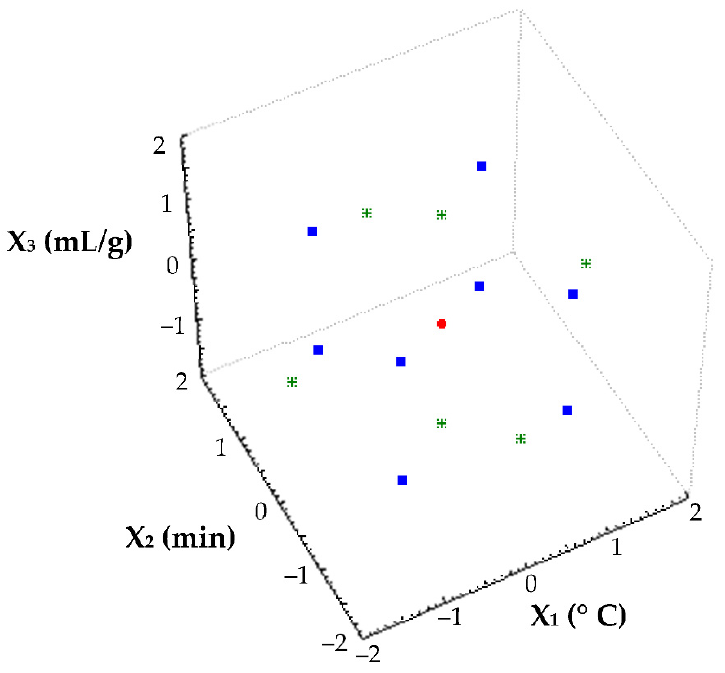
Figure 1. Standard CCD characteristics, eight cube points (blue squares), six star points (green crosses), and six center points (red circles).